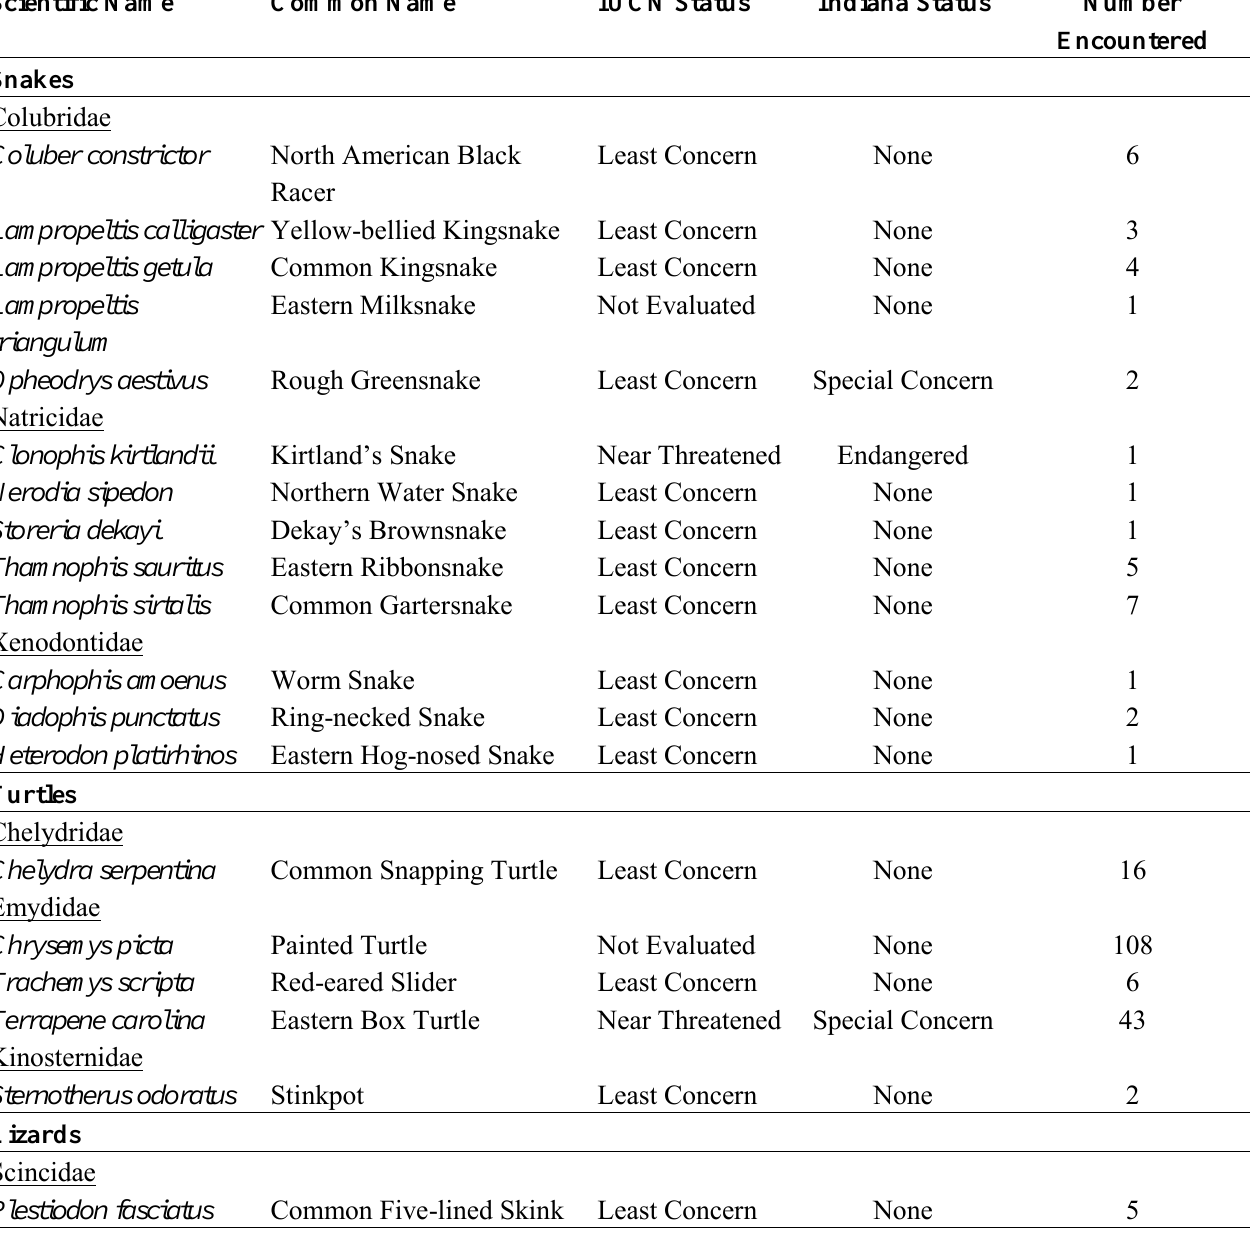
Table 2. Reptile species and numbers (adults and